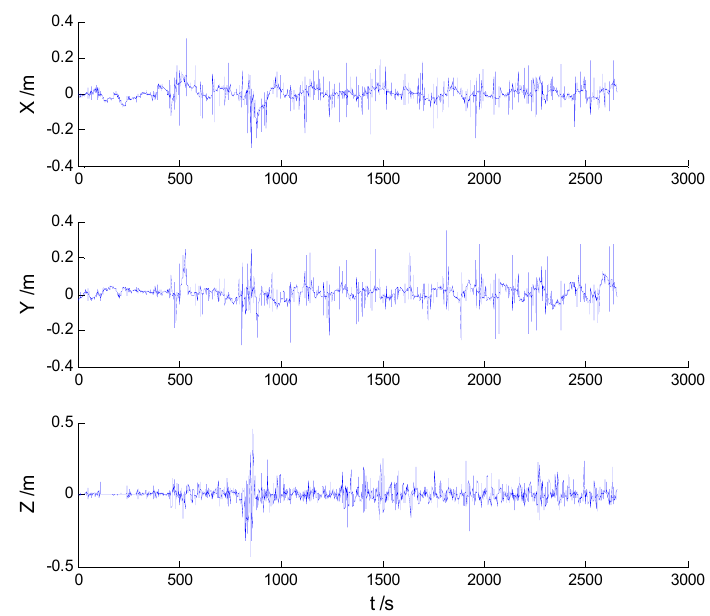
Figure 2. Position errors of the Kalman filter (KF) algorithm.